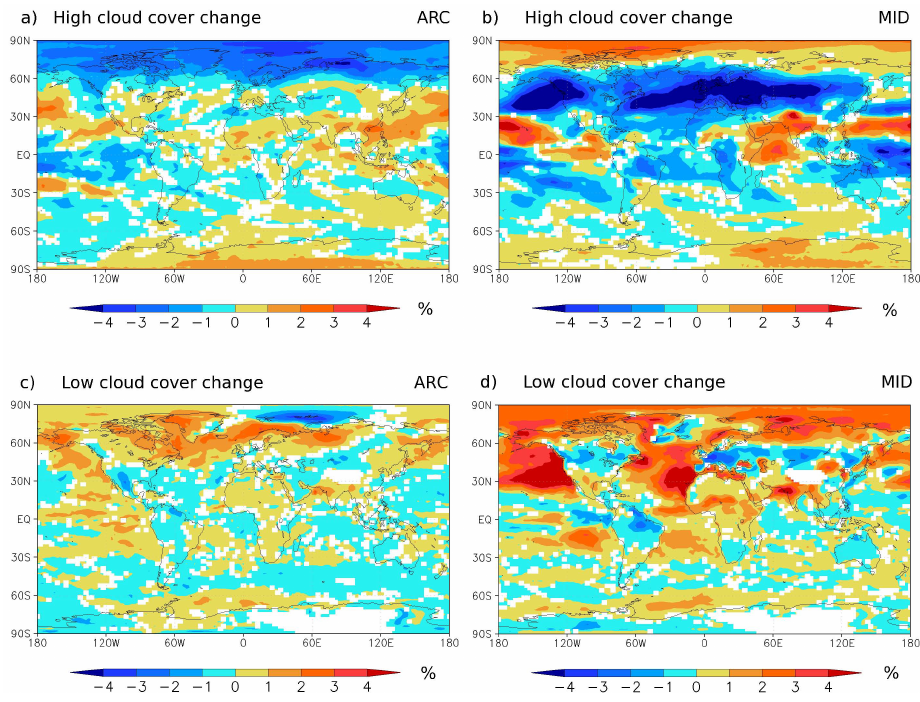
Fig. 9. Annual mean cloud cover change (in %) for high clouds (top) and low clouds (bottom) for ARC-CONTROL (left) and the MID- CONTROL (right). White areas are not significant on a 95% level.